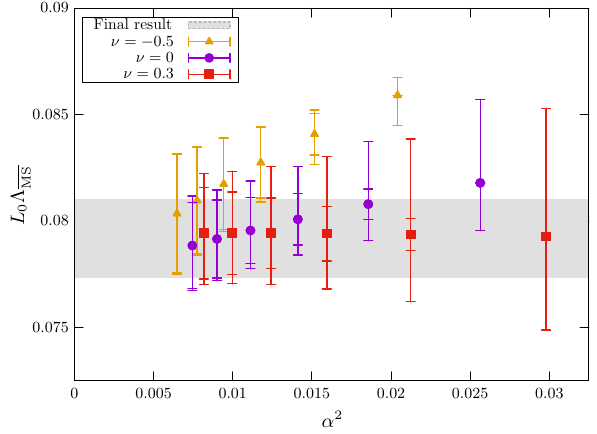
( s ) and c ν ( s ) for two different SF ν schemes. Left ν = 0, right ν = − 0 . 5. The values s (cid:20) defined by the condition c Fig. 6 Coefficients c ν 1 2 are approximately s (cid:20) ≈ 3 (left) and s (cid:20) ≈ 5 (right)